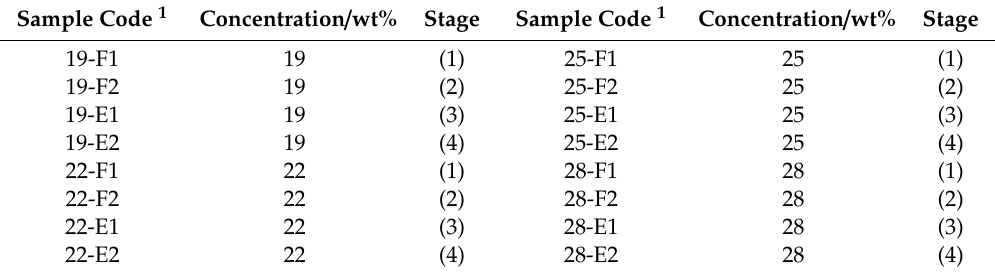
Table 1. Sample codes of various concentrations of regenerated silk fibroin (RSF) from 4 stages of the spinning